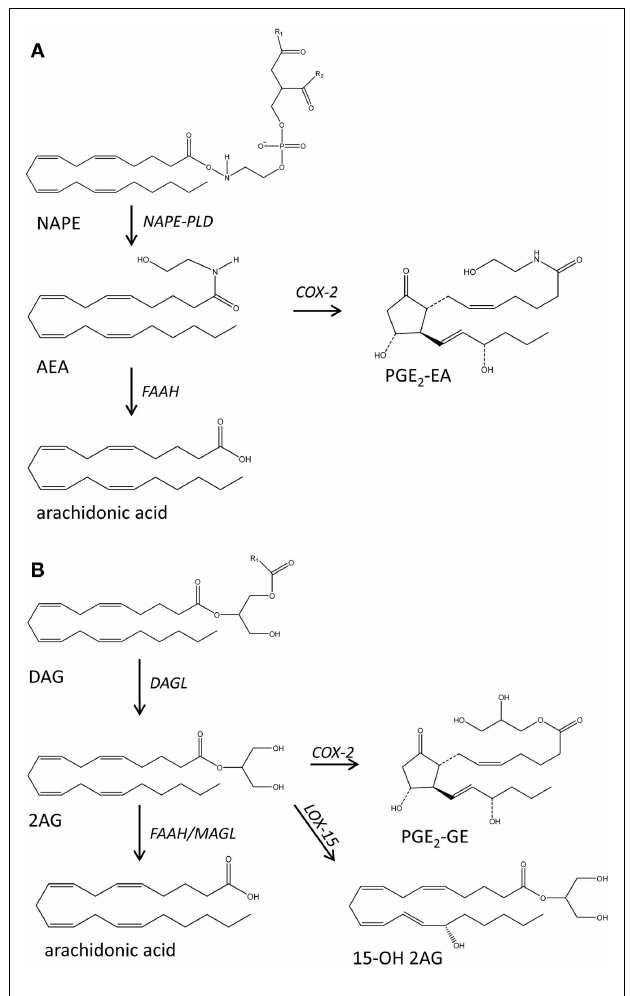
metabolites with significantly reduced bioactivities (e.g., 15-keto- and 13,14-dihydro-15-keto PGs)